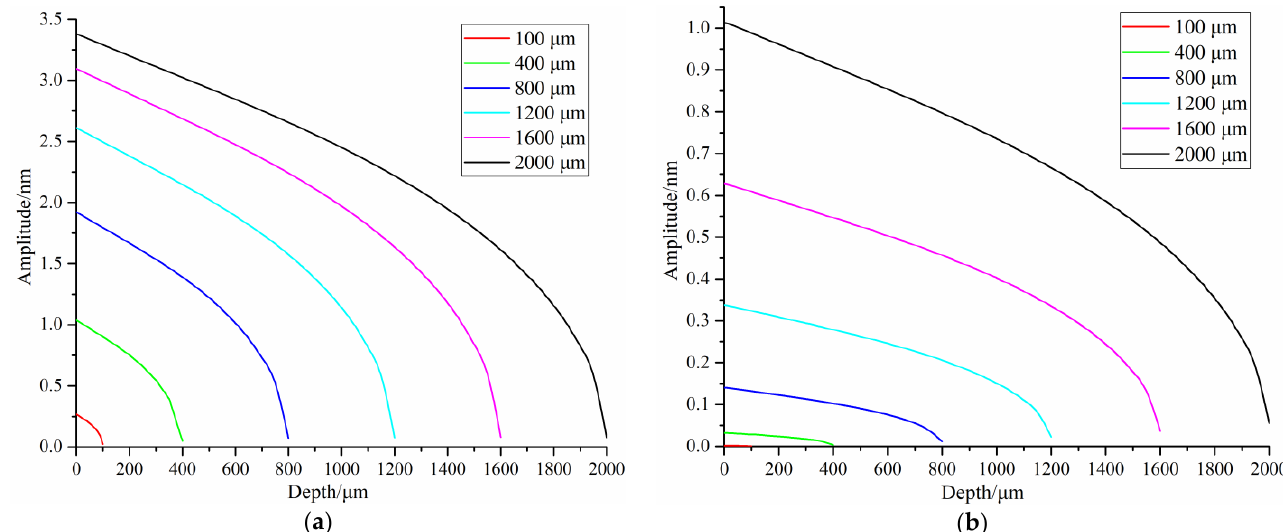
Figure 5. Crack-opening displacement produced by: ( a ) normal stress; ( b ) shear stress.